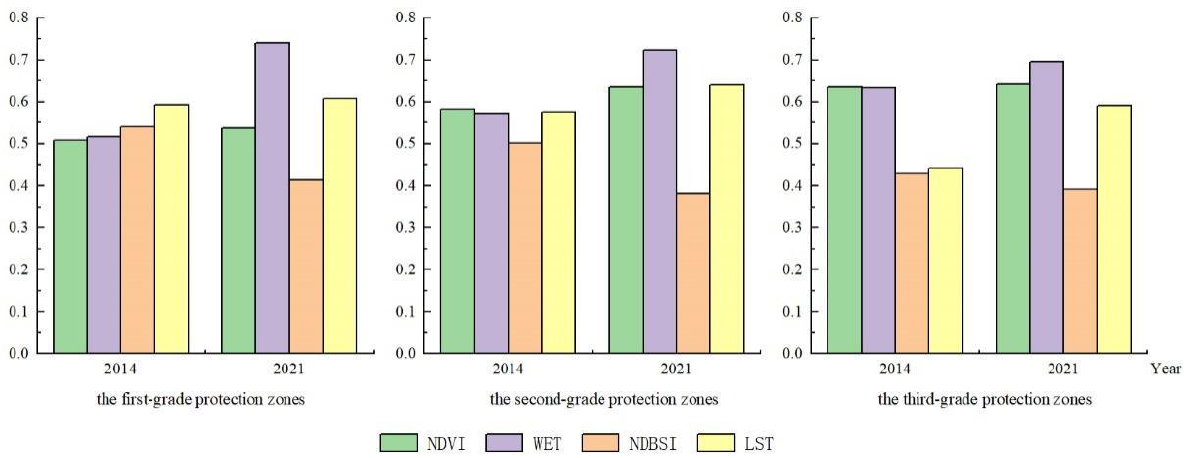
Figure 5. The mean changes in the normalized indices of ecological factors in the three zones.